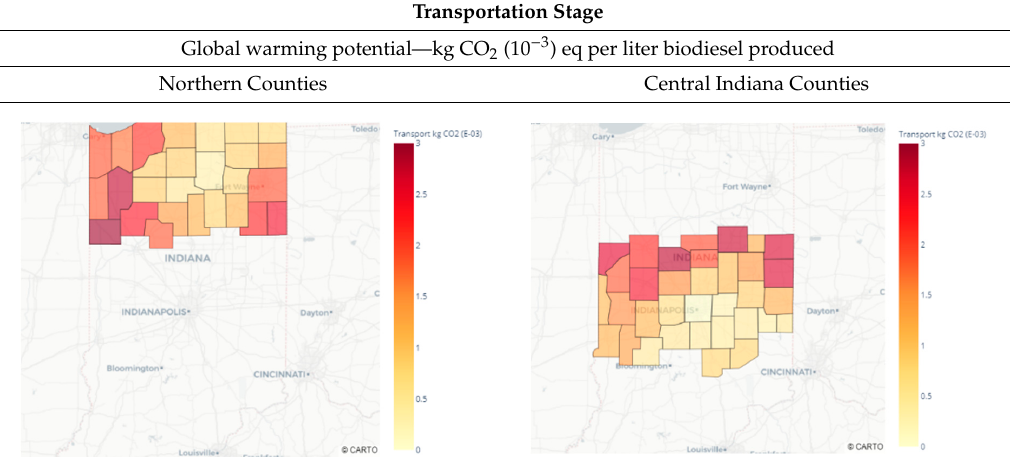
Table 3. Cont . Transportation